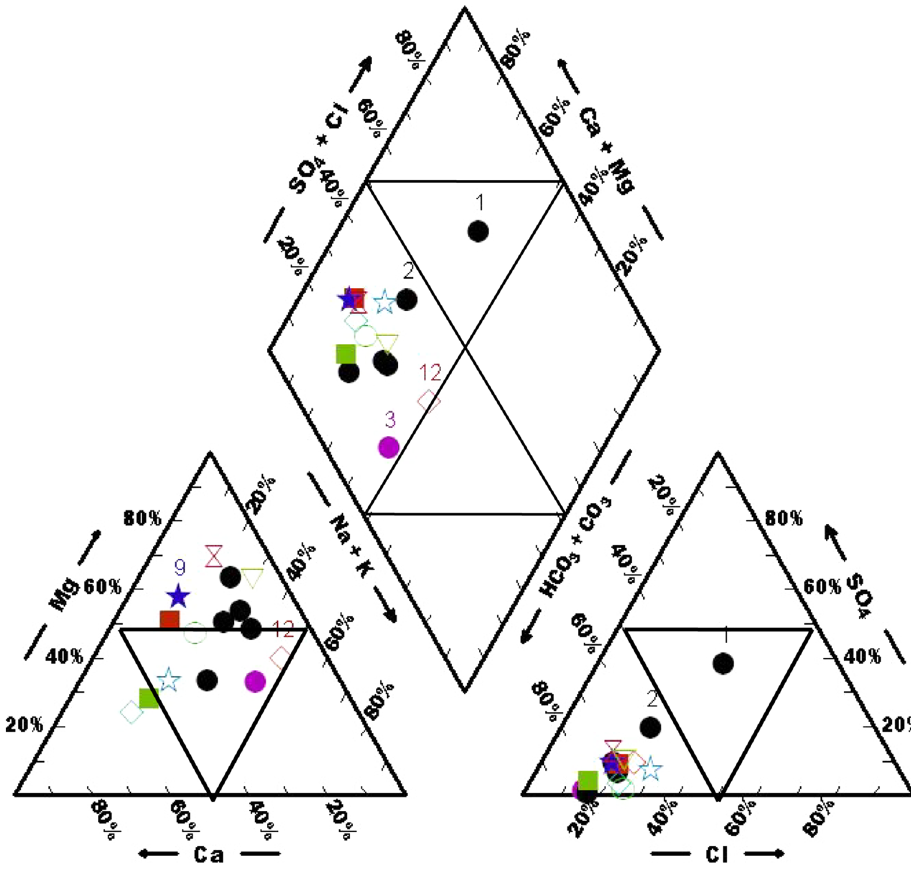
Fig. 3 Piper trilinear diagram showing the relative cation and anion composition of ground- water samples